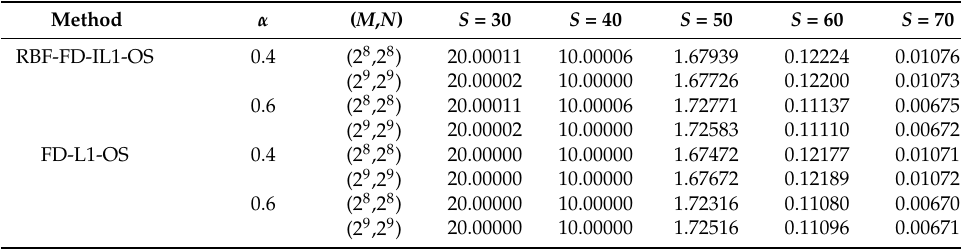
Table 4. Values of American put options using the RBF-FD-IL1-OS and FD-L1-OS methods, where M and N are the number of points in S and t ,